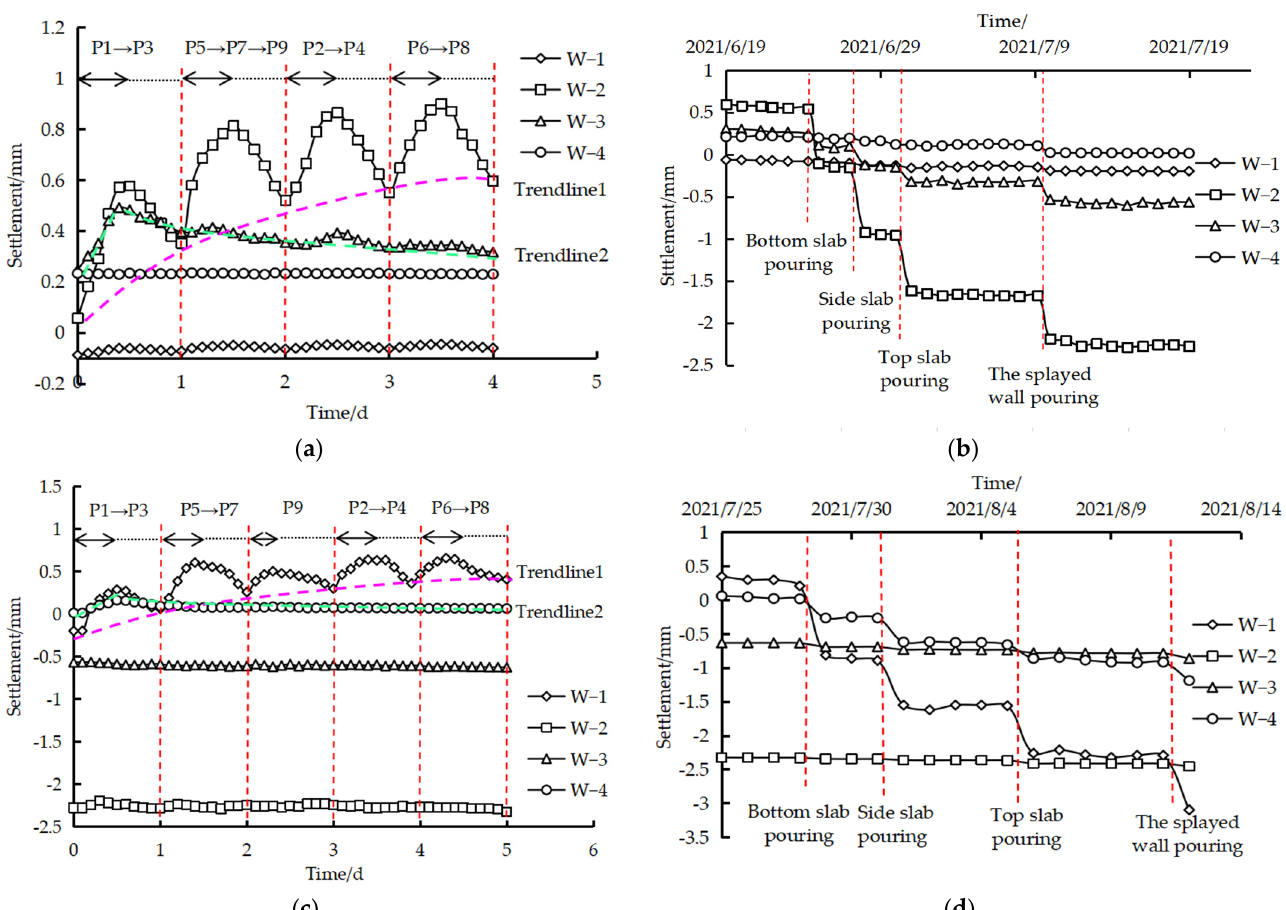
Figure 10. Relation curve of level gauge deformation with the construction time of each stage (Site 1): ( a ) composite foundation treatment of uplink side; ( b ) culvert extension structure construction of uplink side; ( c ) composite foundation treatment of downlink side; ( d ) culvert extension structure construction of downlink side.